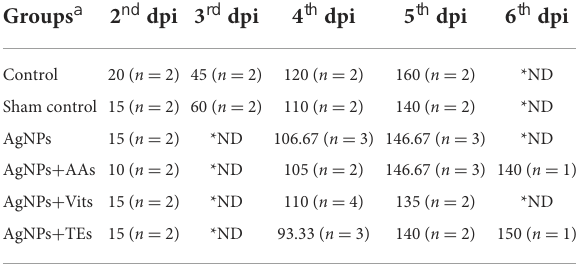
TABLE 8 Effect of in ovo administration of silver nanoparticles (AgNPs) and critical nutrients on the average scores of gross pathological lesions in different treatment groups (dpi